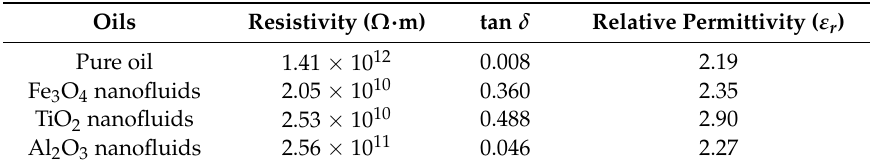
Table 4. Typical dielectric properties of mineral insulating oil and